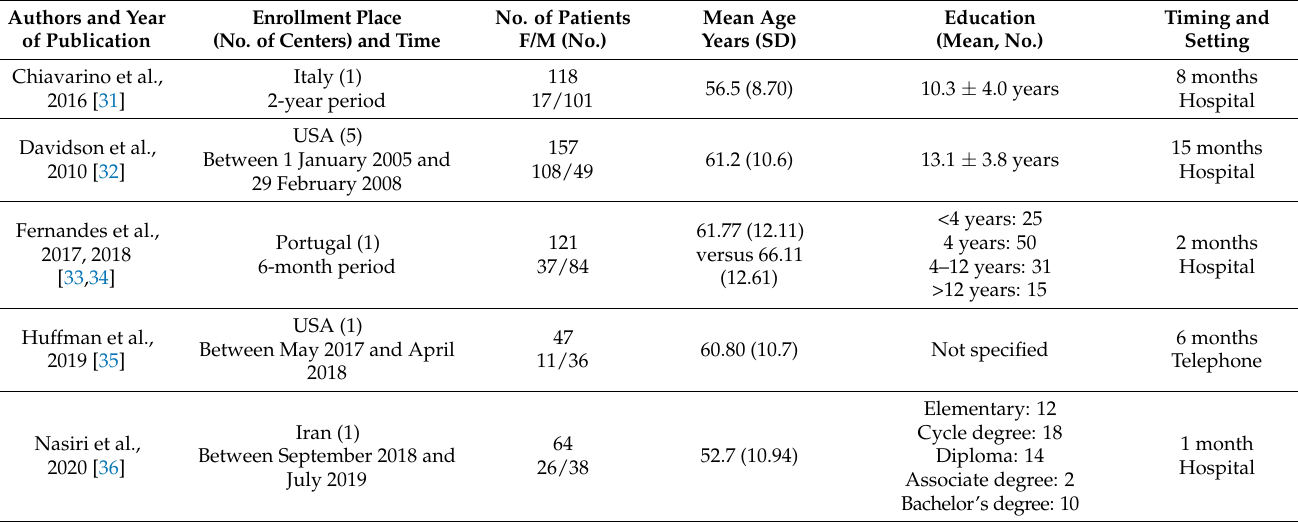
Table 1. General characteristics of studies included in present systematic review .